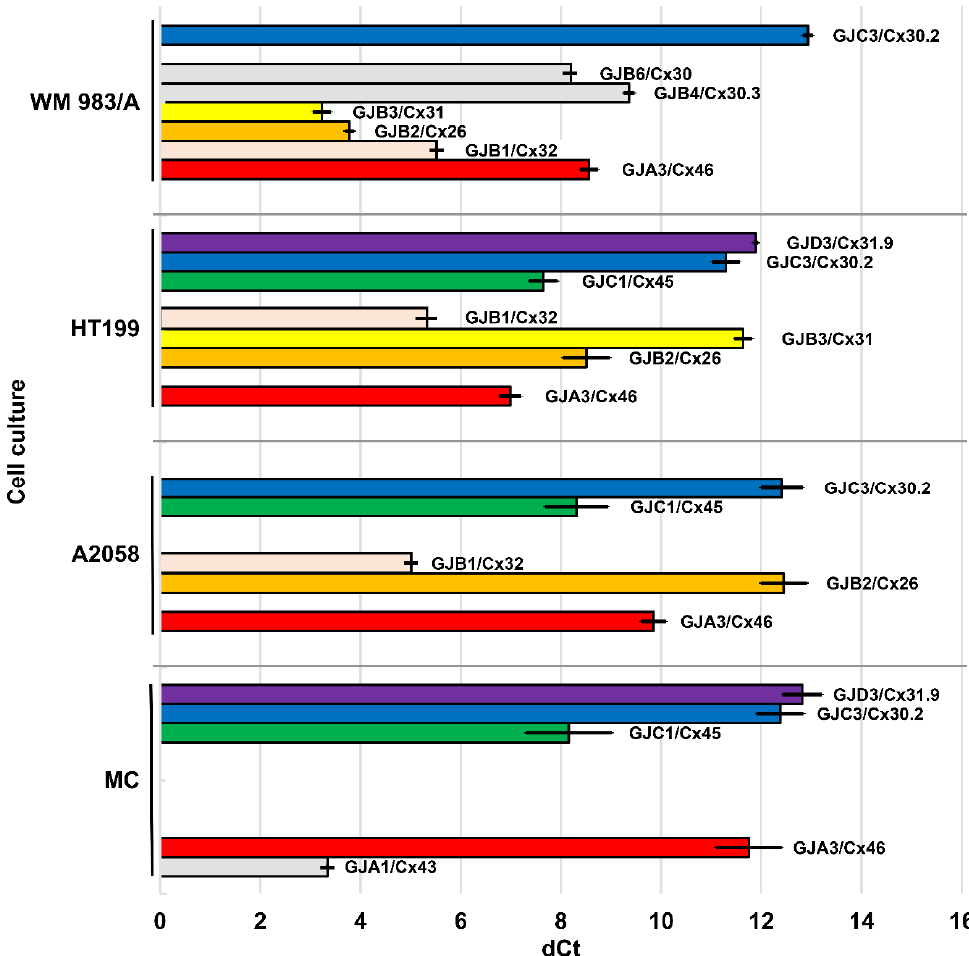
Figure 1. Connexin gene expression in cultured primary melanocytes (MC) and melanoma cell lines A2058, WM983/A and HT199. Threshold cycles of connexin gene expressions were compared to that of the housekeeping beta actin as a reference (dCt). Genes expressed in more than one cell line are colored. Black lines show ±SD of at least three independent isolations. Connexin genes expressed at highest levels (shortest bars) were GJA1 (Cx43) in MC, as well as GJB2 (Cx26) and GJB3 (Cx31) in WM 983/A, and GJB1 (Cx32) in all three melanoma cell lines.